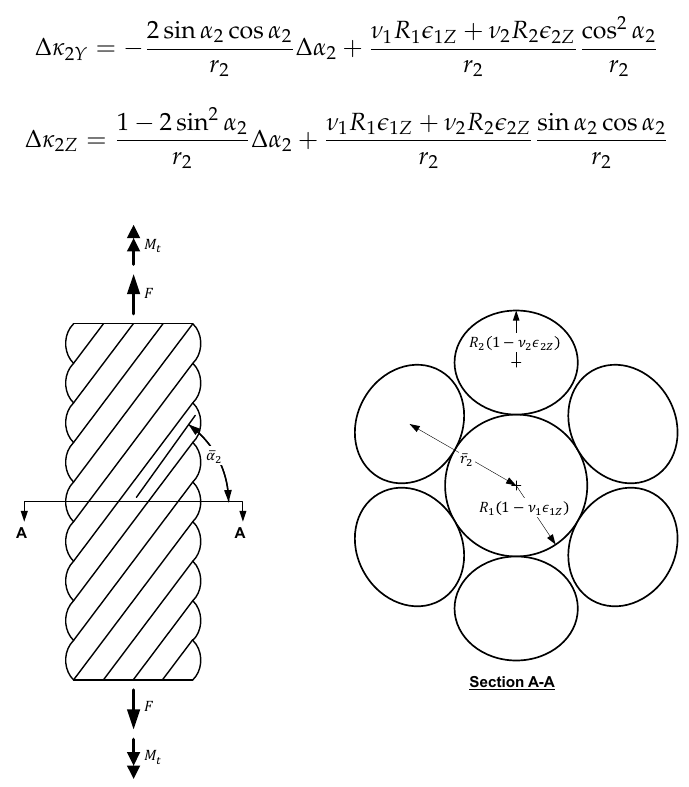
Figure 2. Geometry of a loaded strand.